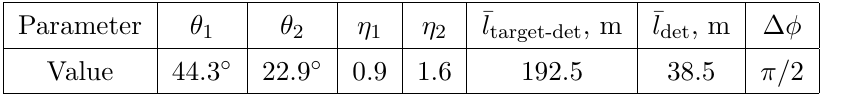
Figure 17 . MATHUSLA experiment geometry. Adapted from